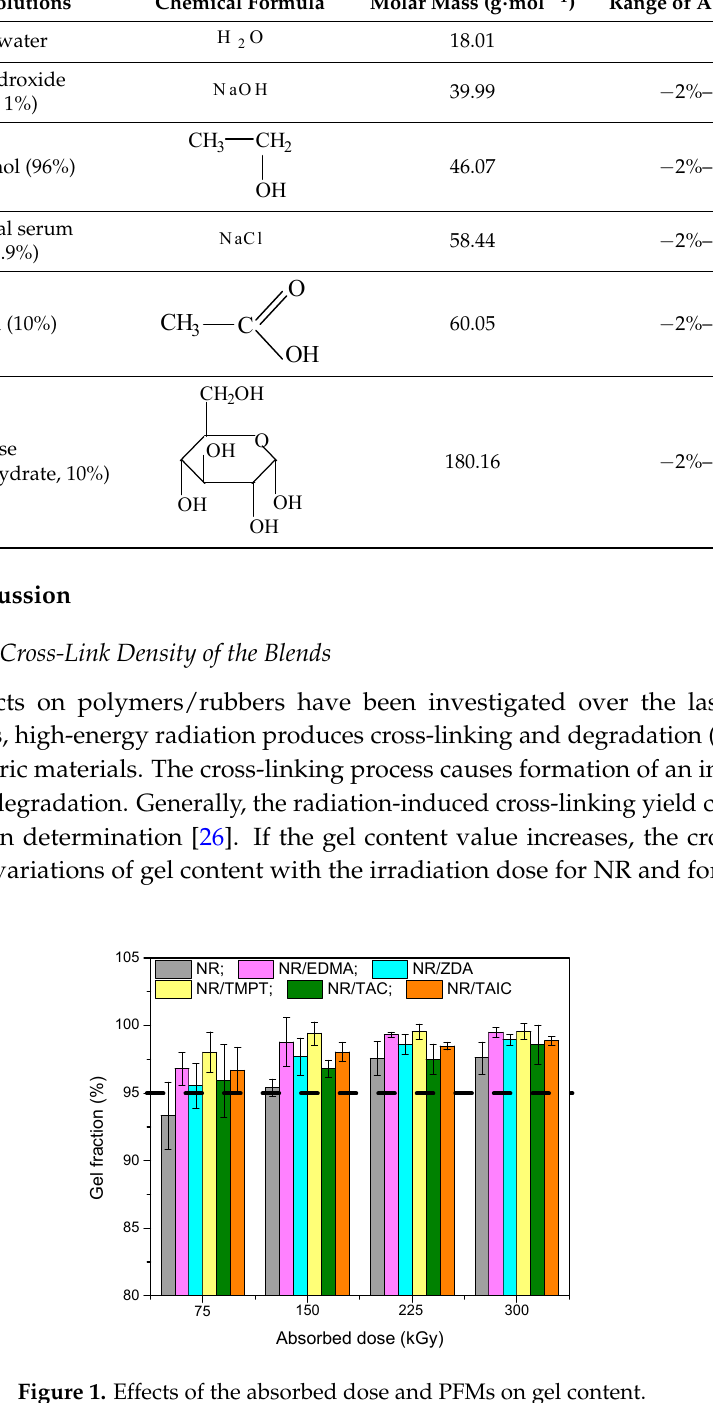
Table 2. The aqueous solutions used for testing the resistance of NR/PFMs samples.